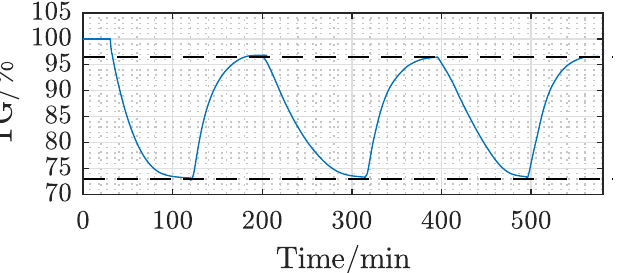
Figure 3. Reaction behavior of Sample 1 (S1) at 700°C and 250mL/min with the gas concentration ro 4 as defined in Table